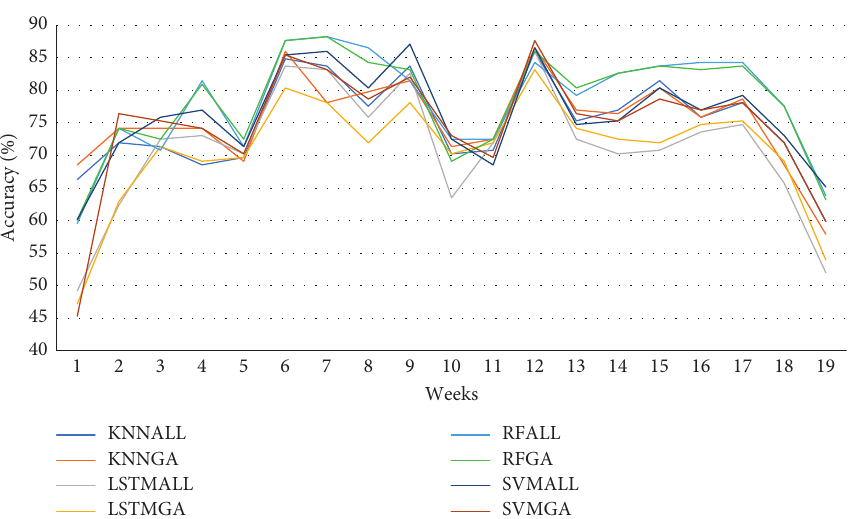
Figure 5: Accuracy changes of single models during the time.